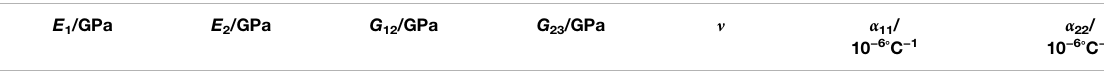
TABLE 1 | Material properties of the unidirectional carbon fi ber composite M40J/602. Material